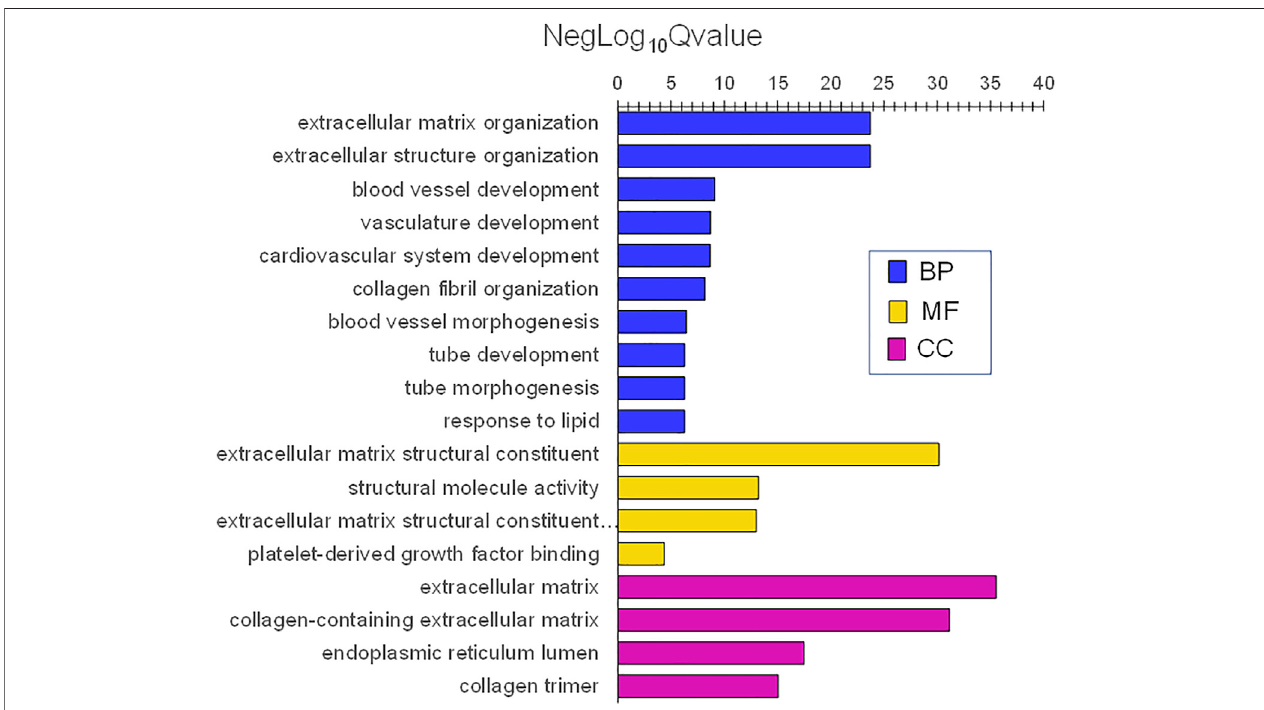
FIGURE 8 | Gene ontology themes with enriched gene expression in infant skin. Signi fi cantly expressed genes were analyzed for enrichment of biologic themes (GeneOntology)usingtheclusterPro fi lerpackage(Yuetal.,2012),EnrichmentMap(Mericoetal.,2010),andg:pro fi ler(Raudvereetal.,2019).Signi fi cantpathwayswere selected using the false discovery rate (FDR)adjusted p values. NegLog 10 Qvalue indicates -Log 10 FDR adjusted p value. The lowest adjusted p values (highest NegLog 10 Qvalue) were biological processes (BP) extracellular matrix (ECM) organization and ECM structure organization. Others included system development (e.g., blood vessel, cardiovascular, tube), and response (e.g., to lipid). The most signi fi cant molecular functions (MF) were ECM matrix structural constituent and structural molecule activity. ECM and collagen-containing ECM were the most signi fi cant cell components